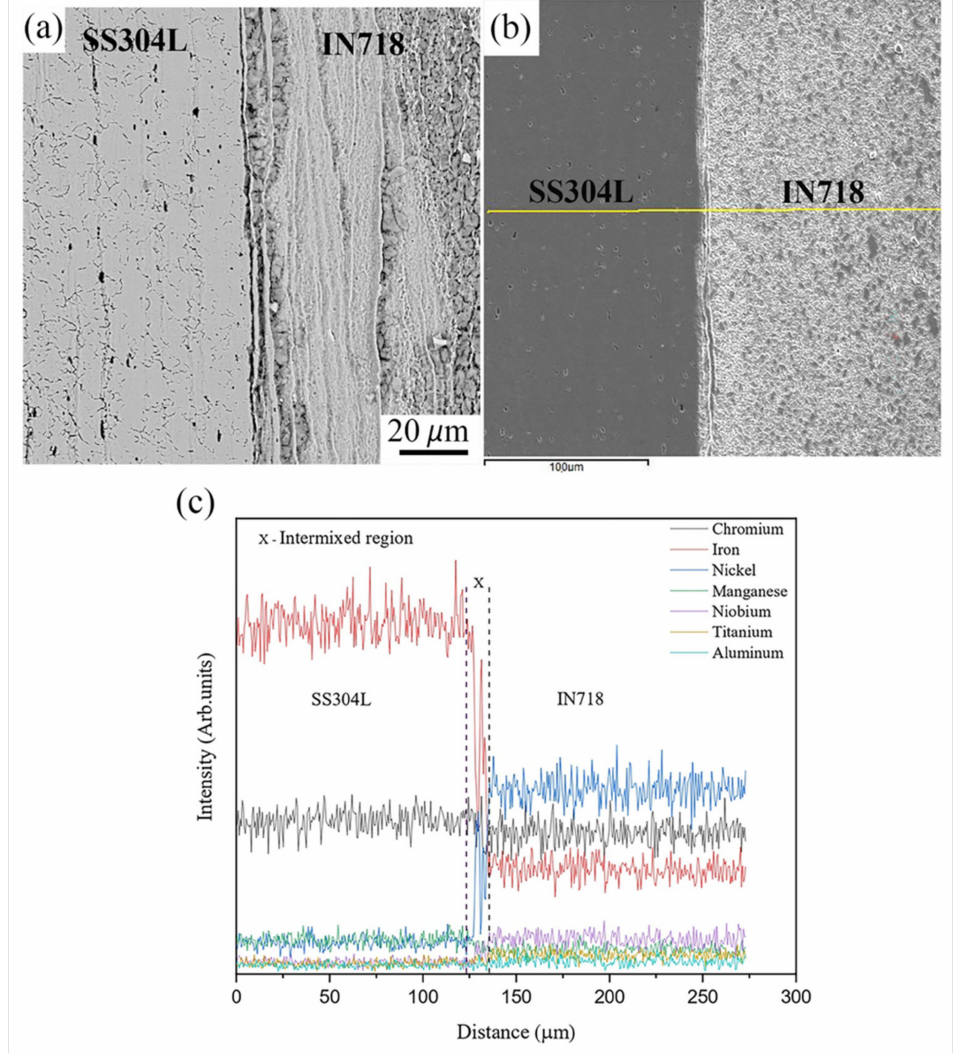
Figure 12. Scanning electron microscopy image in the secondary electron mode ( a ) inter-mixed Region ( b ) SS304L/IN718 in the as-welded ST condition and ( c ) the corresponding energy dispersive spectroscopy (EDS) line